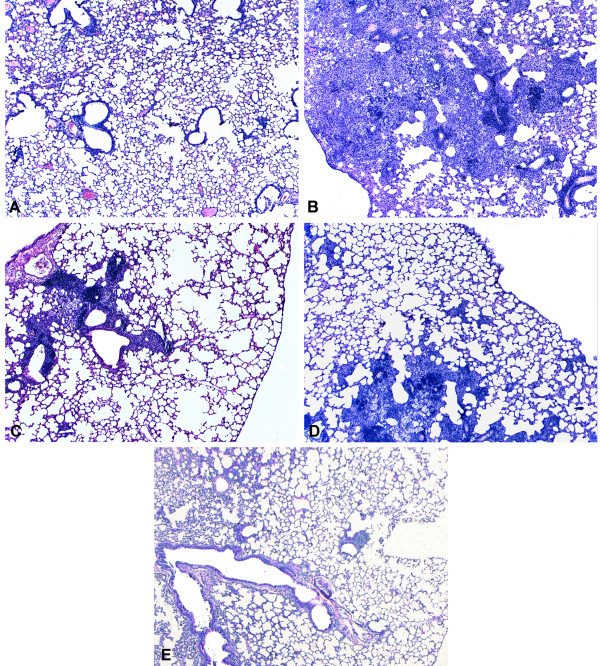
Comparison of lung parenchyma from mice immunized with COMP-hsp65 or naked hsp65. Lung sections of mice immunized with one intranasal dose of COMP-hsp65 (25 μg) were compared with lung sections from mice that received four intramuscular doses of naked DNA (400 μg), BCG or saline. Thirty days after the last dose, mice were challenged intra-tracheally with M. tuberculosis H37RV and 30 days post infection we performed histological analysis of the lung. (A) non-infected; (B) saline; (C) naked hsp65; (D) COMP-hsp65 and (E) BCG groups. Representative sections of HE staining. Magnifications: ×65.